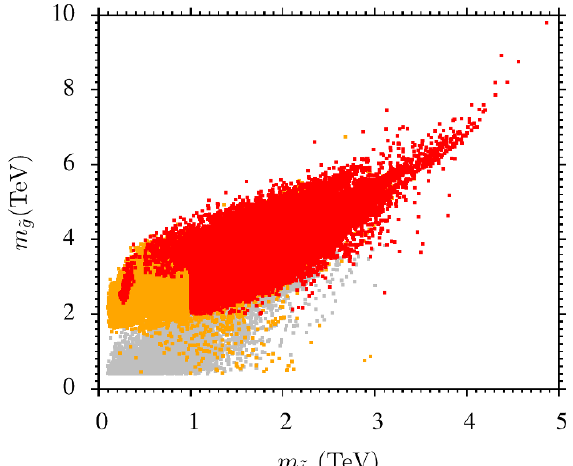
Figure 1 . Result of our scan displayed on the lightest stop-gluino mass plane. All points ful(cid:12)l our ‘naturalness condition’, (cid:1) EW (cid:20) 100. Grey points satisfy the REWSB, yield a neutralino LSP and are consistent with LEP bounds. Orange points give in addition a Higgs mass in the range (3.4), while red points also satisfy B -physics and the LHC bounds described in section